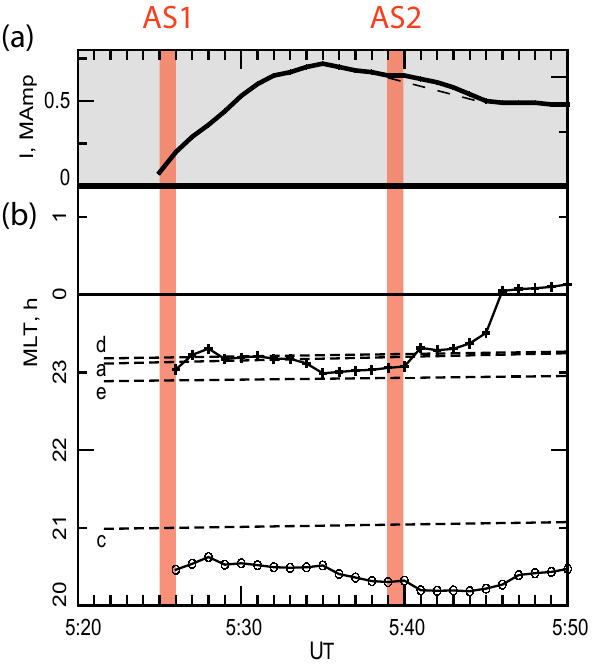
Fig. 9. Reconstructed substorm current wedge (SCW) using THEMIS and INTERMAGNET ground magnetometer data. The longitudinal locations of upward and downward FACs as well as their magnitude as a function of time were modeled to fit the mid- latitude magnetic variations. The vertical red bars mark 5-min in- tervals during which both auroral spirals occurred. (a) Current in- tensity of the SCW (note that the dashed line follows the earlier trend and is not modeled data). (b) Longitude in MLT of downward FAC (crosses), upward FAC (circles), and footprints of TH-A, TH- C, TH-D, and TH-E (dashed lines) (modified from Keiling et al., 2009).